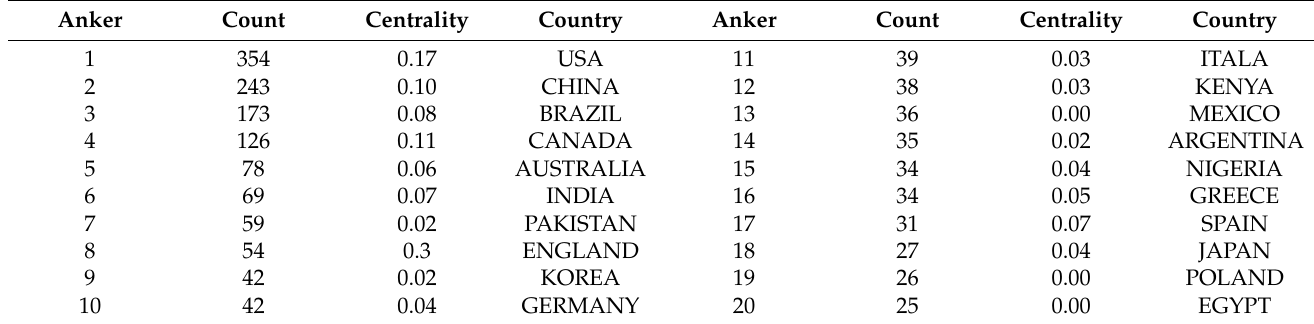
Table 3. Information table of the top 20 major research countries with the published article.